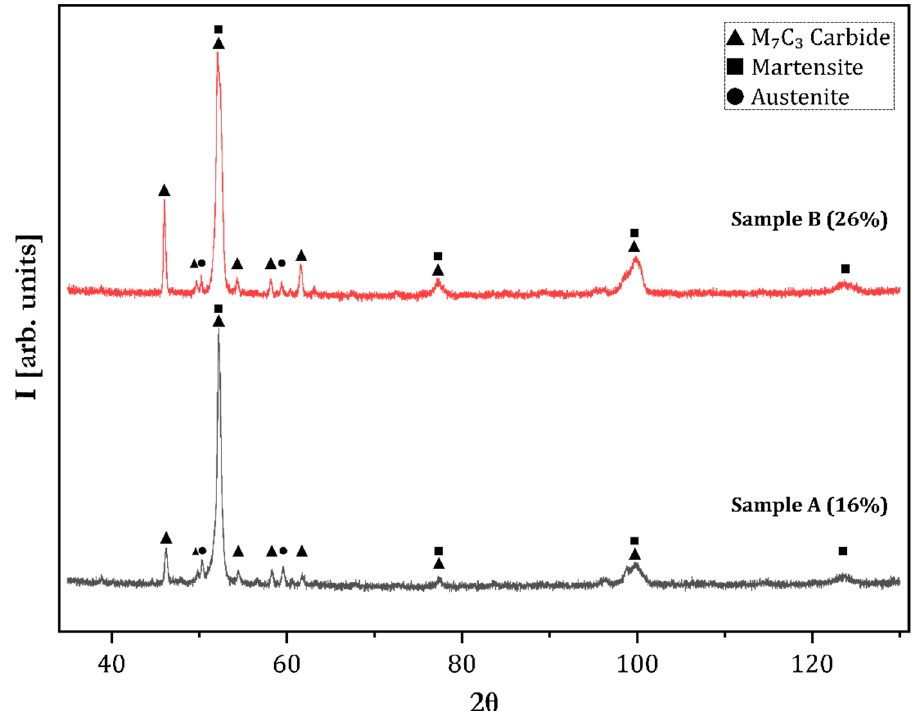
Figure 2. X-ray diffractograms of samples A and B. Austenite, martensite, and the M 7 C 3 carbide are indexed for reference.